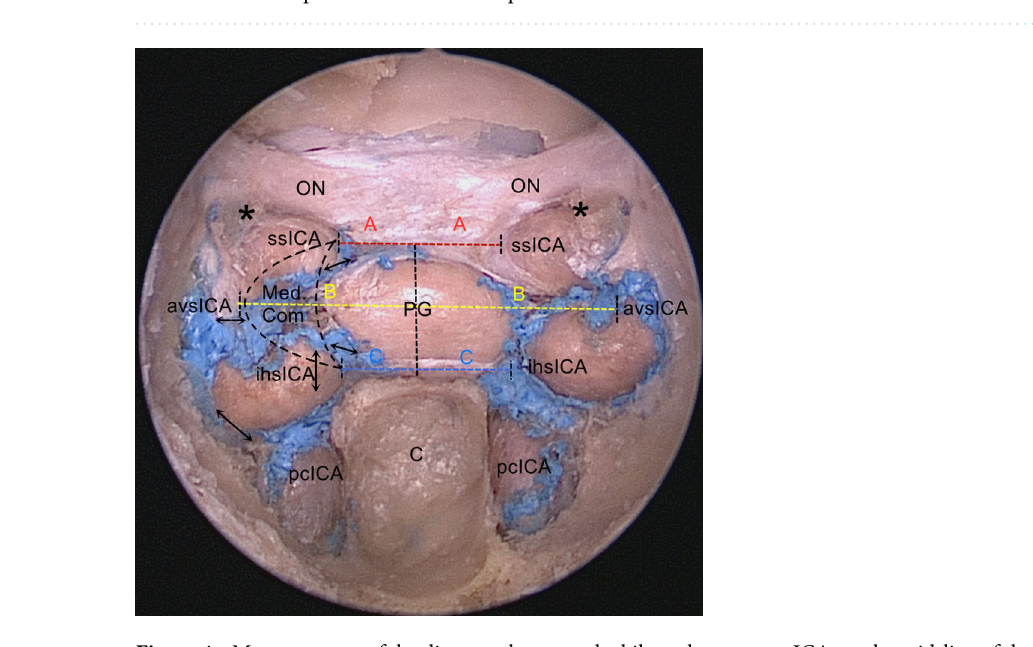
Figure 4. Measurements of the distances between the bilateral cavernous ICAs to the mid-line of the PG in endoscopic view and the medial compartment resembles C-shape (the black dotted line), A (the red dotted line) represents the distance from the medial border of the upper cavernous ICA (subarachnoid segment) to the mid-line of the PG, B (the yellow dotted line) is the distance between the medial border of the anterior vertical segment of cavernous ICA to the mid-line of the PG, C (the blue dotted line) marks the distance from the medial border of the lower cavernous ICA (inferior horizontal segment) to the mid-line of the PG, the medial C-shaped compartment communicates with the anteroinferior compartment anteroinferiorly, the lateral compartment laterally and the posterosuperior compartment posteriorly, also crosses the anterior and inferior intercavernous sinus medially to the opposite compartment (arrows). PG pituitary gland, C clivus, ON optic nerve, ihsICA inferior horizontal segment of the ICA, ssICA subarachnoid segment of the ICA, pcICA paraclival segment of the ICA, *Opticocarotid